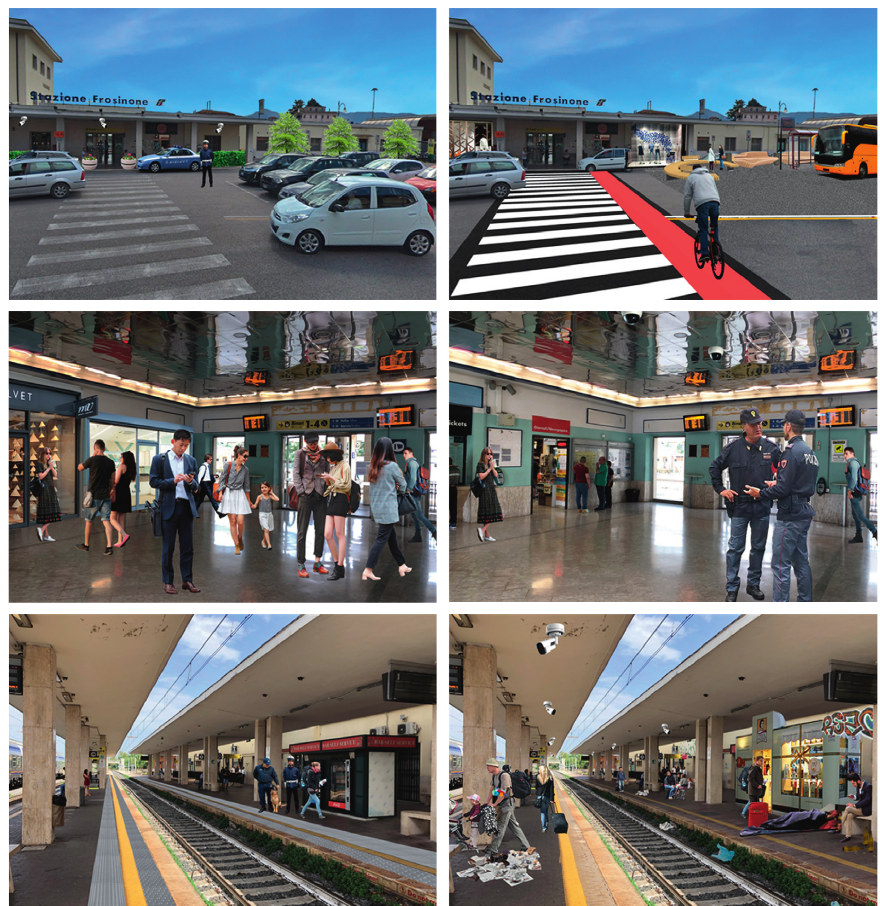
Figure 1: Examples of the figures of the